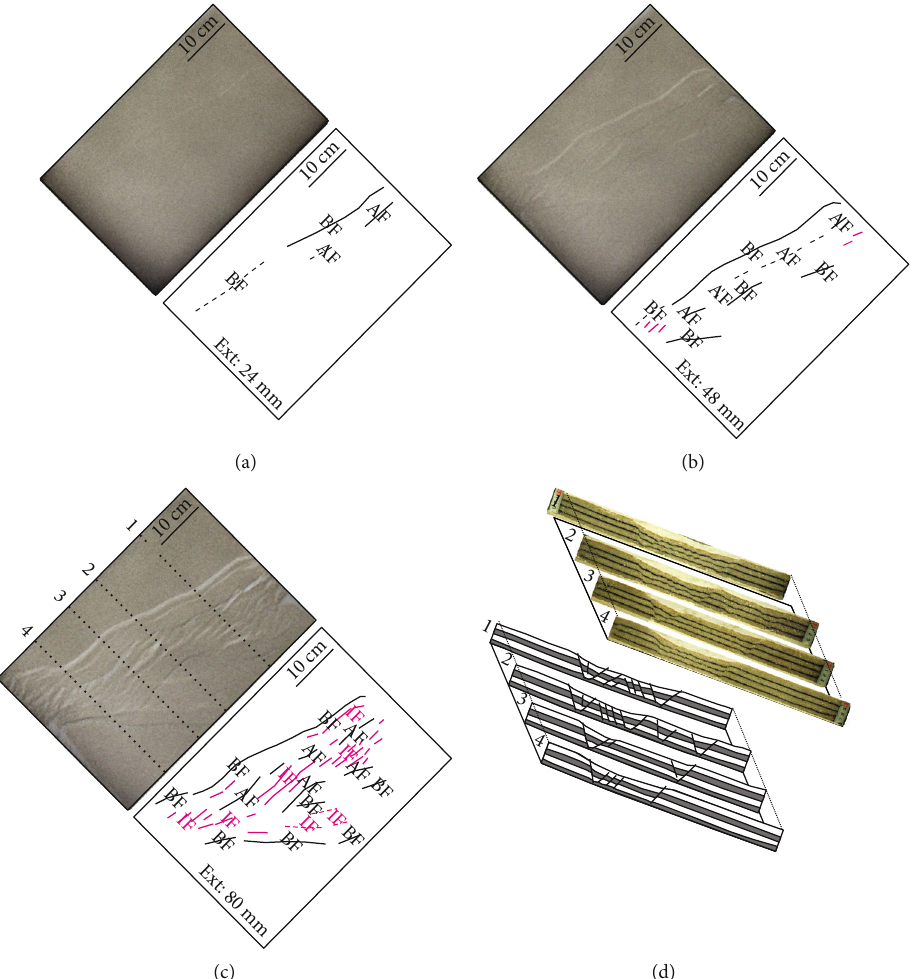
Figure 4: Evolution and characteristics of deformation in model 2, with a higher extension rate. (a – c) Top-view photos (left panels) and schematic line-drawings of structures (right panels), illustrating boundary faults (BF), antithetic faults (AF), and internal faults (IF). (d) Vertical cross sections corresponding to locations in (c).